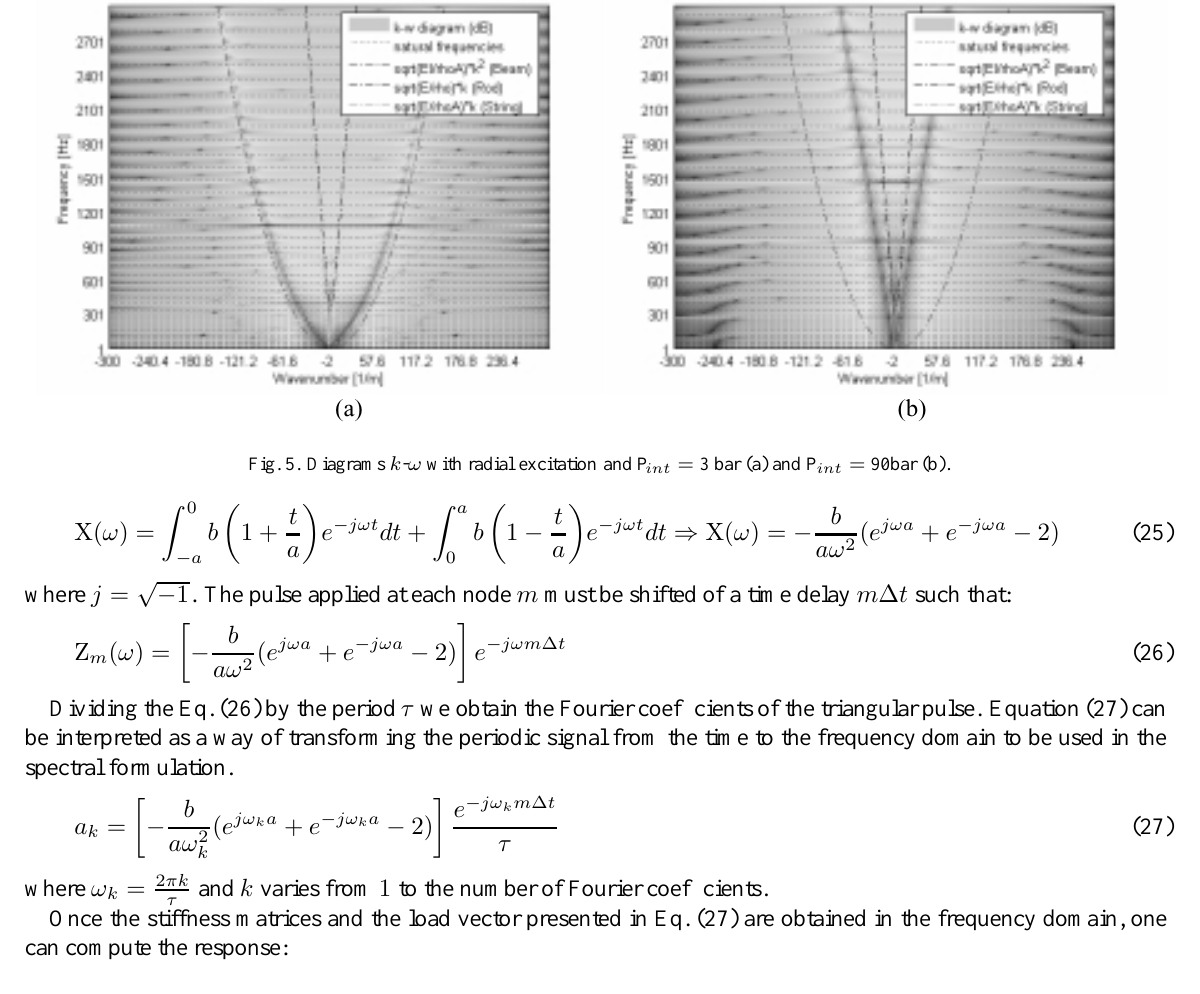
Fig. 5. Diagrams k - ω with radial excitation and P int = 3 bar (a) and P int = 90bar